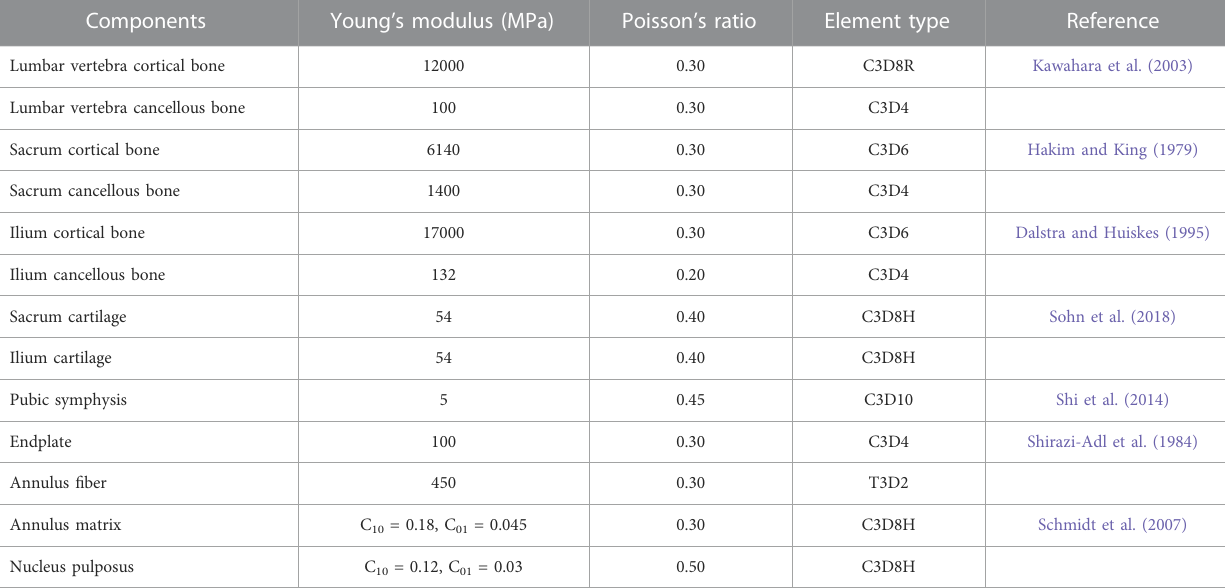
TABLE 1 Material properties of the lumbopelvic fi nite element